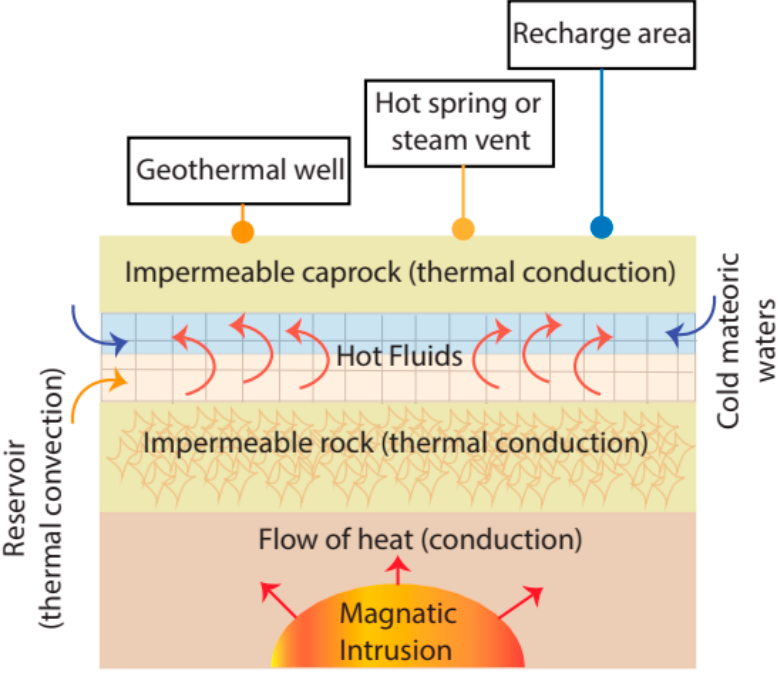
Figure 1. Illustration of a perfect geothermal system.